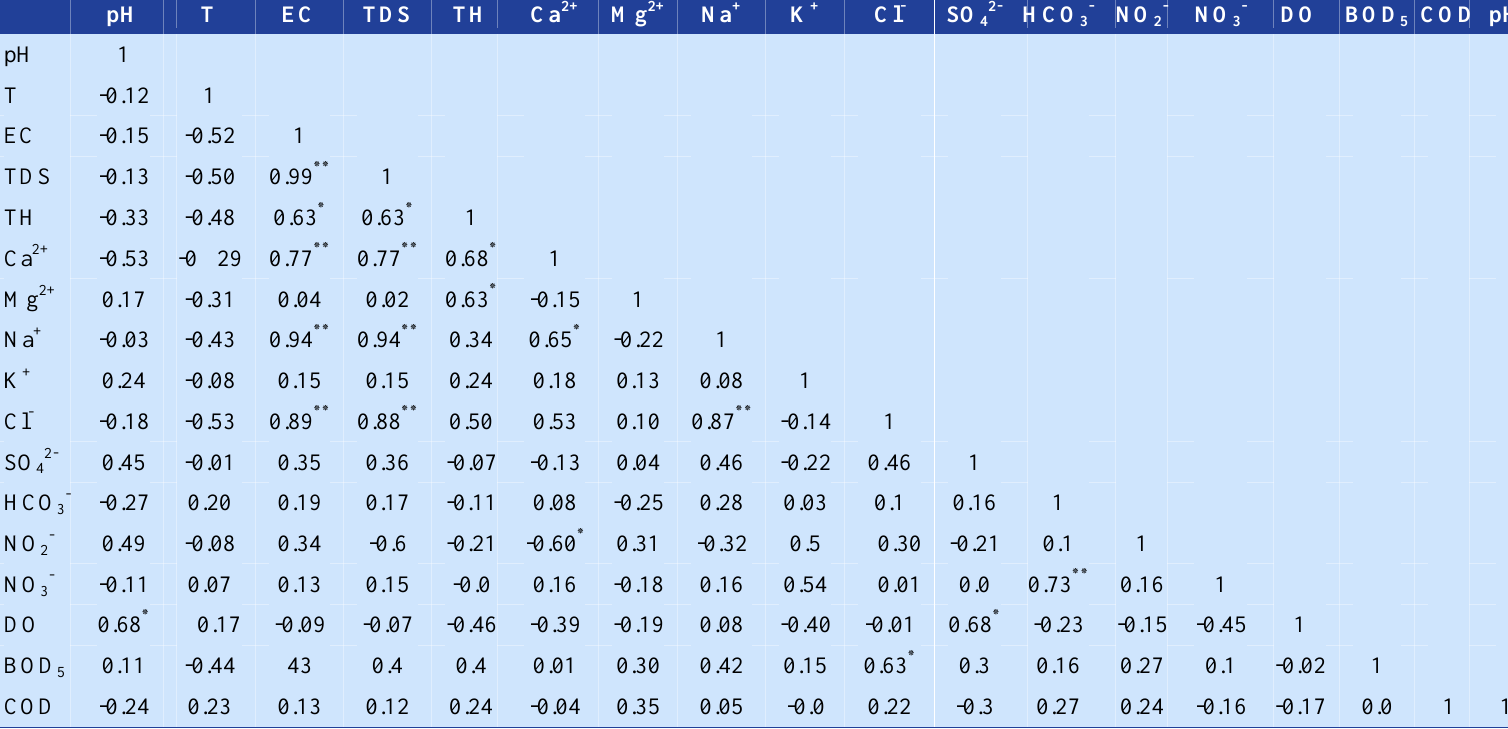
Table 3. Pearson’s correlation coefficients of parameters surface water in Birjand, Iran flood plain